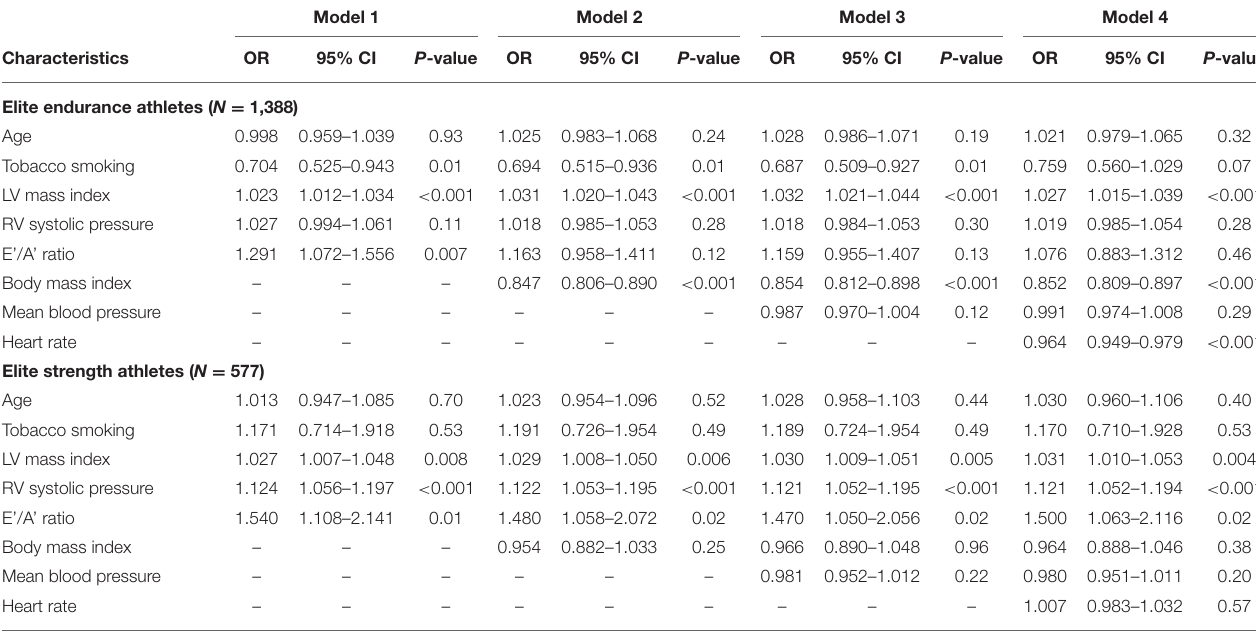
TABLE 4 | Multivariable logistic regression analysis for elite endurance and strength